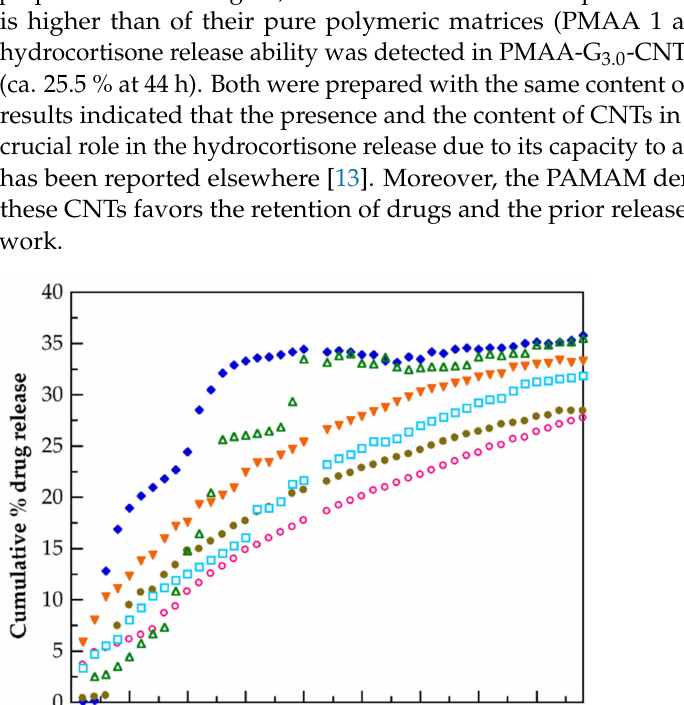
), PMAA 2 ( • ), PMAA-G 3.0 -CNTs 1 ( (cid:72) ), (cid:35) ), and PMAA-G 3.0 -CNTs 4 ( (cid:52) (cid:50)